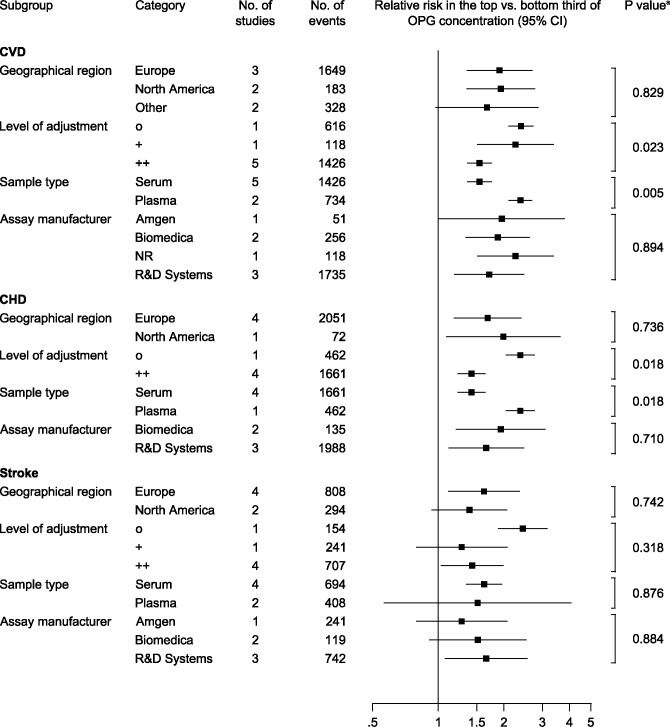
Relative risks for cardiovascular outcomes in the top vs bottom third of osteoprotegerin concentration according to categories of study characteristics.aP values were derived from meta-regression. Levels of adjustment: o, unadjusted; +, adjusted for age and sex; ++, additionally adjusted for at least one non-blood based risk factor and one blood-based risk factor.